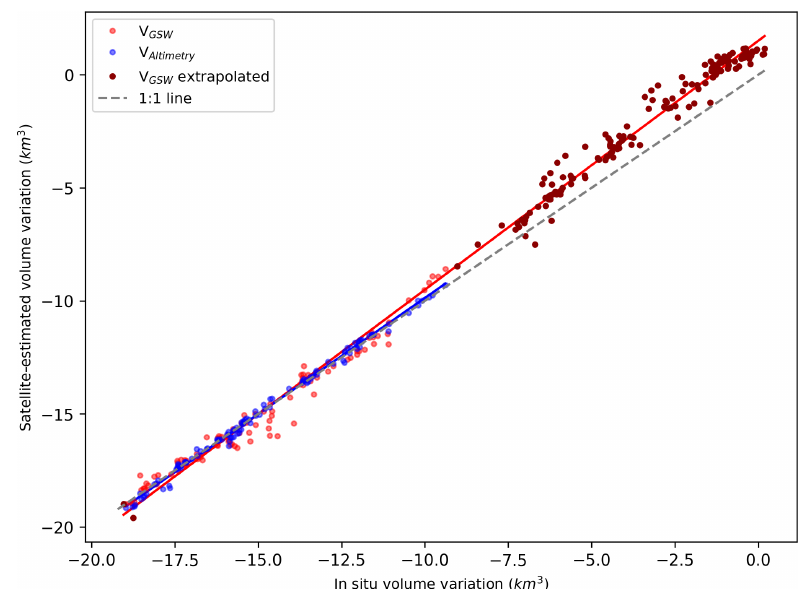
Figure 8. Relationship in volume variation between satellite-estimated and in situ observations for Lake Mead, with a Pearson r >0.99 and